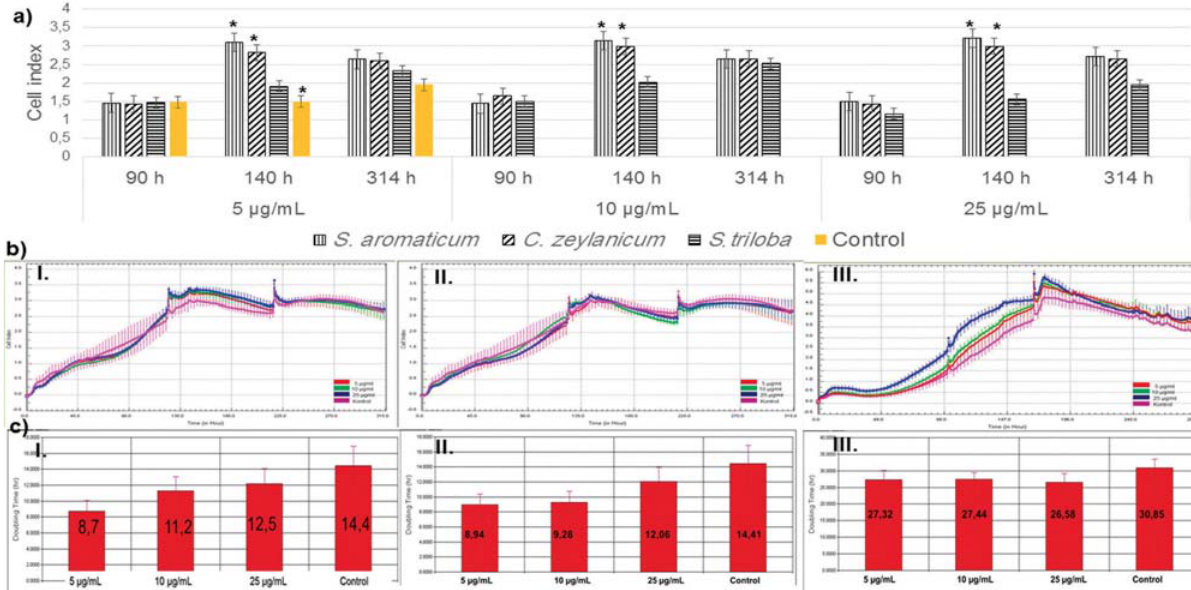
Figure 3- xCELLigence analysis of dental pulp stem cells (DPSCs) treated with 5, 10, and 25 μ g/mL of the Extracts. a: Cell index of DPSCs (cid:68)(cid:87)(cid:3)(cid:24)(cid:15)(cid:3)(cid:20)(cid:19)(cid:15)(cid:3)(cid:68)(cid:81)(cid:71)(cid:3)(cid:21)(cid:24)(cid:3)(cid:151)(cid:74)(cid:18)(cid:80)(cid:47)(cid:30)(cid:3) S. aromaticum and C. zeylanicum growth curve of the cells with S. aromaticum (cid:3)(cid:68)(cid:87)(cid:3)(cid:20)(cid:23)(cid:19)(cid:3)(cid:75)(cid:3)(cid:11)(cid:69)(cid:17)(cid:44)(cid:12)(cid:30)(cid:3) C. zeylanicum (b.II) and S. triloba (cid:3)(cid:11)(cid:69)(cid:17)(cid:44)(cid:44)(cid:44)(cid:12)(cid:3)(cid:71)(cid:76)(cid:73)(cid:73)(cid:72)(cid:85)(cid:72)(cid:71)(cid:3)(cid:73)(cid:85)(cid:82)(cid:80)(cid:3)(cid:87)(cid:75)(cid:72)(cid:3)(cid:55)(cid:85)(cid:92)(cid:83)(cid:68)(cid:81)(cid:3)(cid:37)(cid:79)(cid:88)(cid:72)(cid:3)(cid:68)(cid:86)(cid:86)(cid:68)(cid:92)(cid:30)(cid:3)(cid:55)(cid:75)(cid:72)(cid:3)(cid:71)(cid:82)(cid:88)(cid:69)(cid:79)(cid:76)(cid:81)(cid:74)(cid:3)(cid:87)(cid:76)(cid:80)(cid:72)(cid:3)(cid:82)(cid:73)(cid:3)(cid:87)(cid:75)(cid:72)(cid:3)(cid:39)(cid:51)(cid:54)(cid:38)(cid:86)(cid:3)(cid:86)(cid:75)(cid:82)(cid:85)(cid:87)(cid:72)(cid:81)(cid:72)(cid:71)(cid:3)(cid:90)(cid:76)(cid:87)(cid:75)(cid:3) S. aromaticum (c.I), C. zeylanicum (c.II), and S. triloba (c.III)